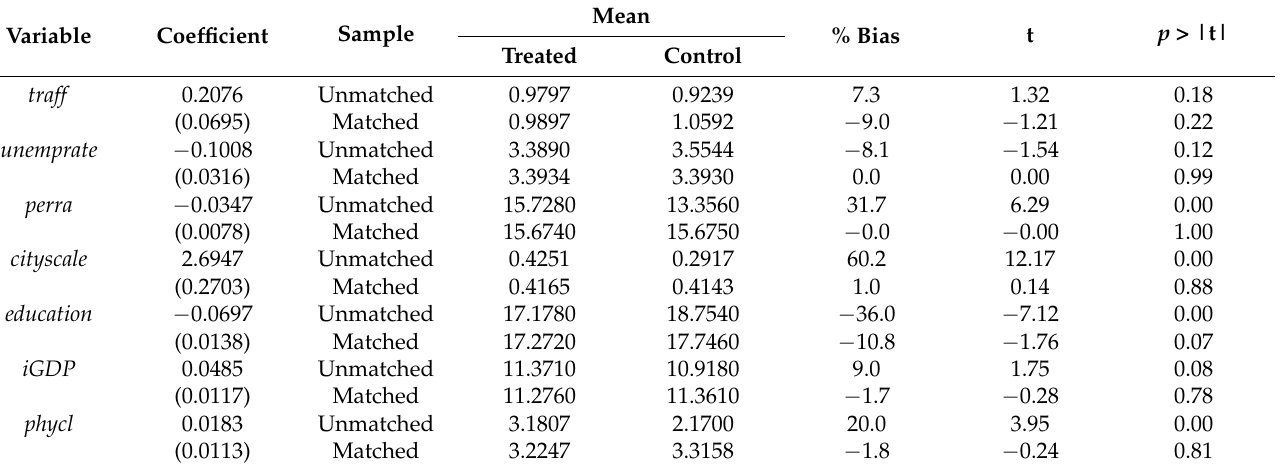
Table 5. PSM and balance test